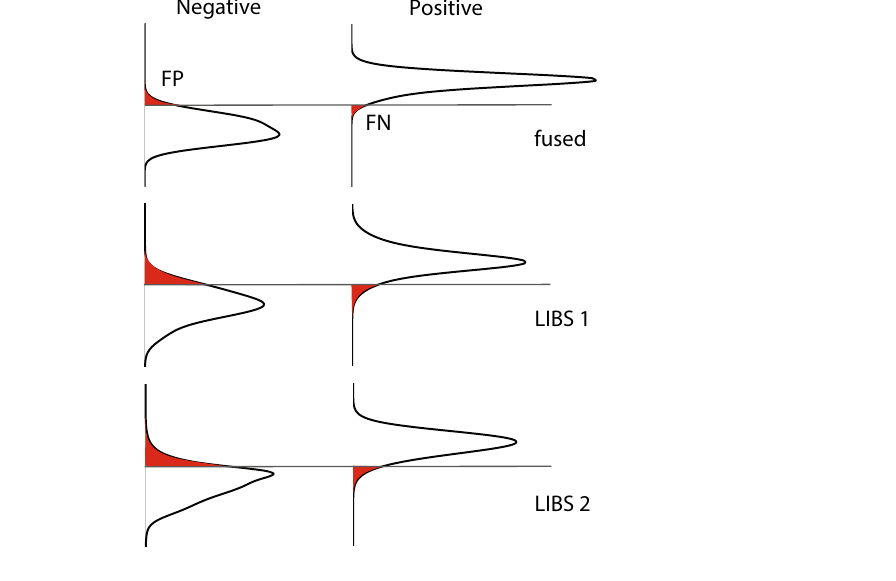
Figure 6. Cumulative probabilities of positive versus negative result in test set of 19